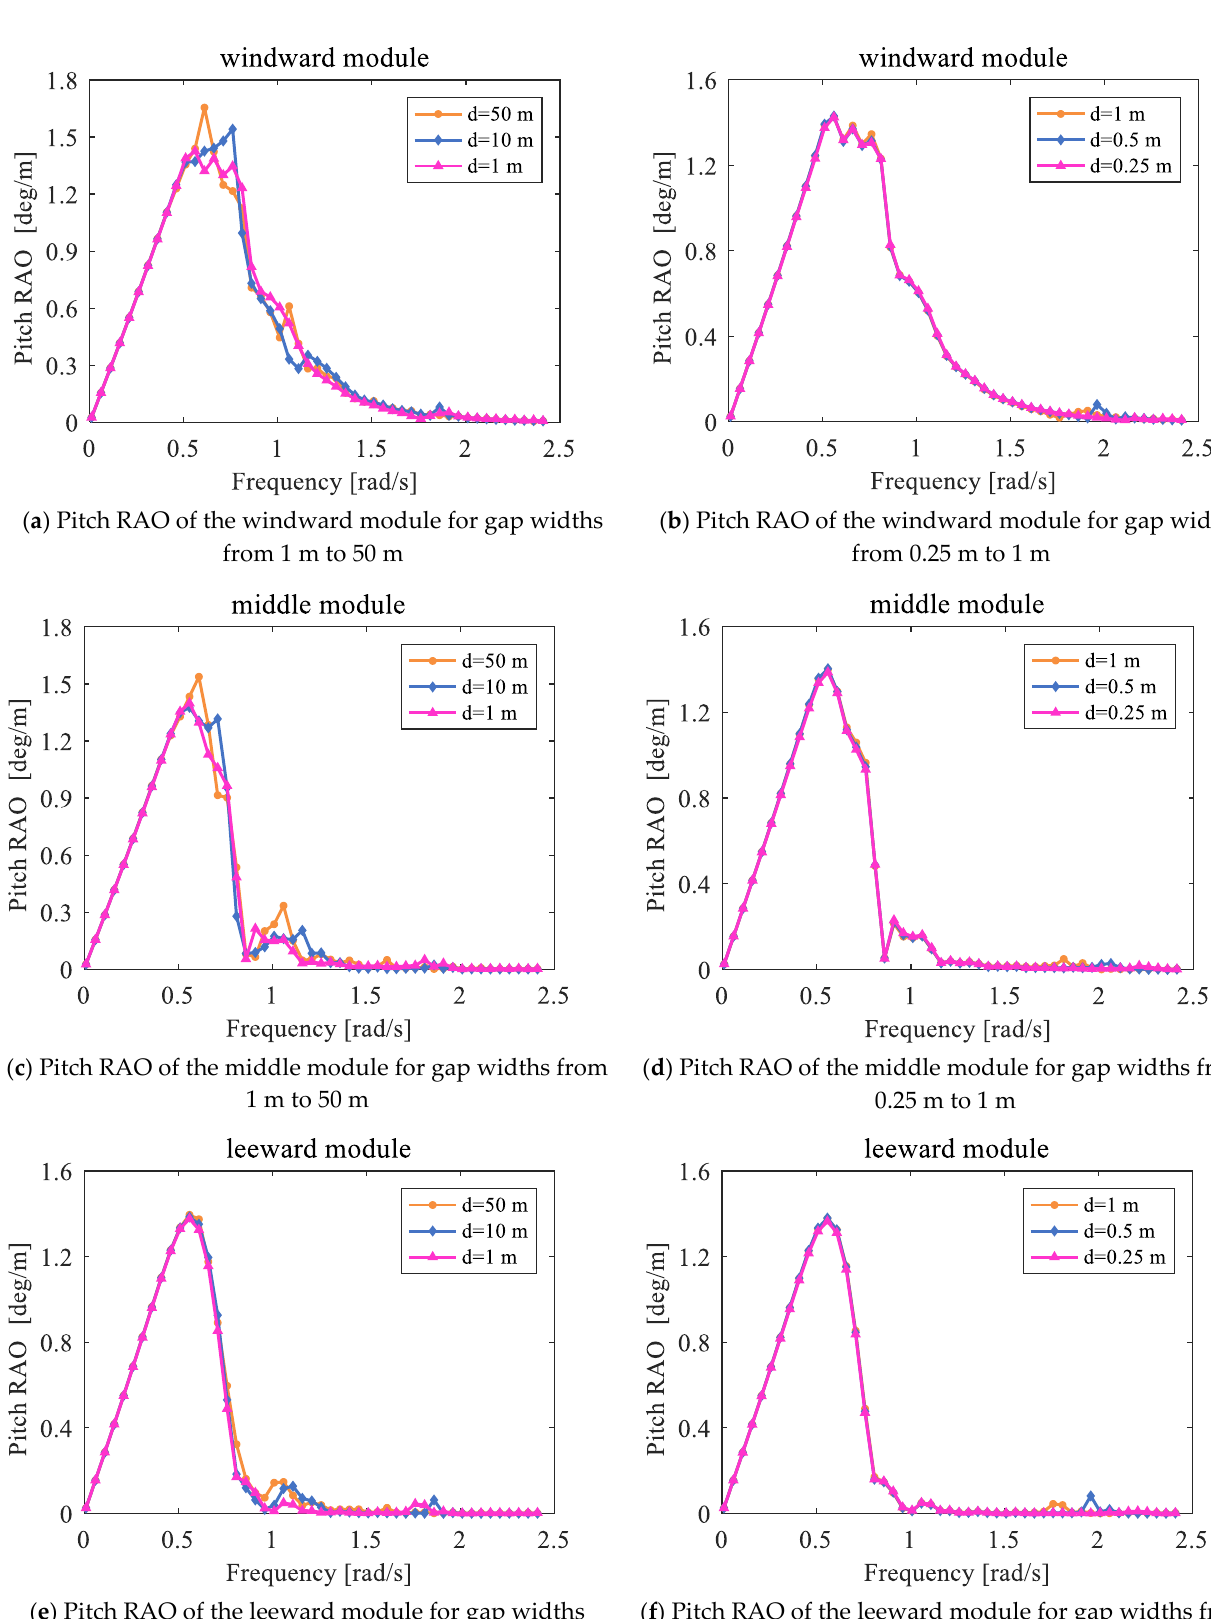
Figure 6. Pitch RAOs of 3-module model in the head sea with different gap widths.